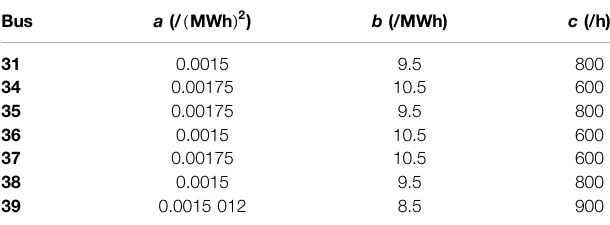
TABLE 1 | Cost of conversational generators.